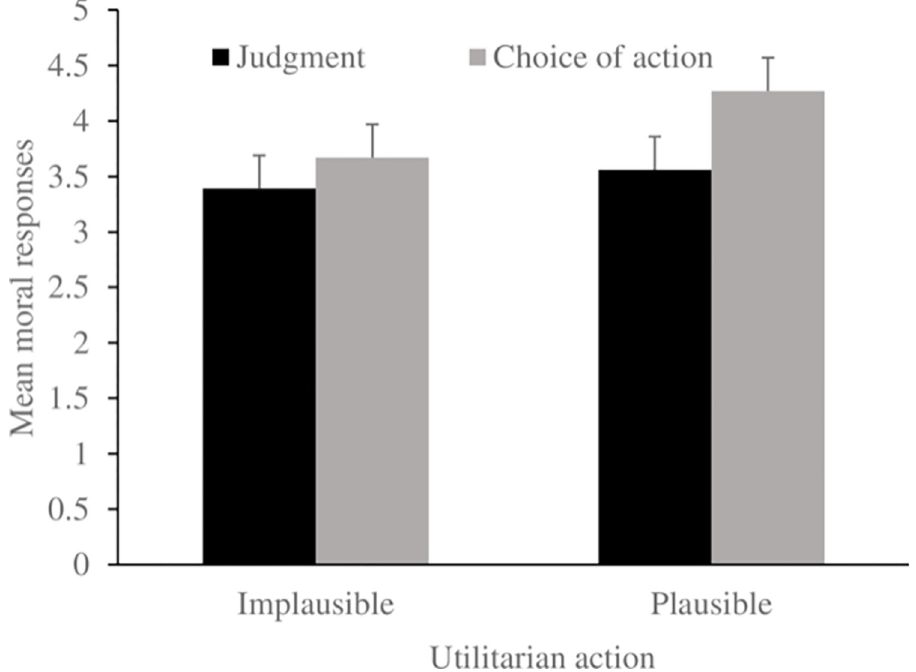
Fig 1. Mean moral responses as a function of type of moral response (judgment vs. choice of action) and plausibility of sacrificial action (plausible vs. implausible). Higher scores (max = 6) are closer to utilitarian